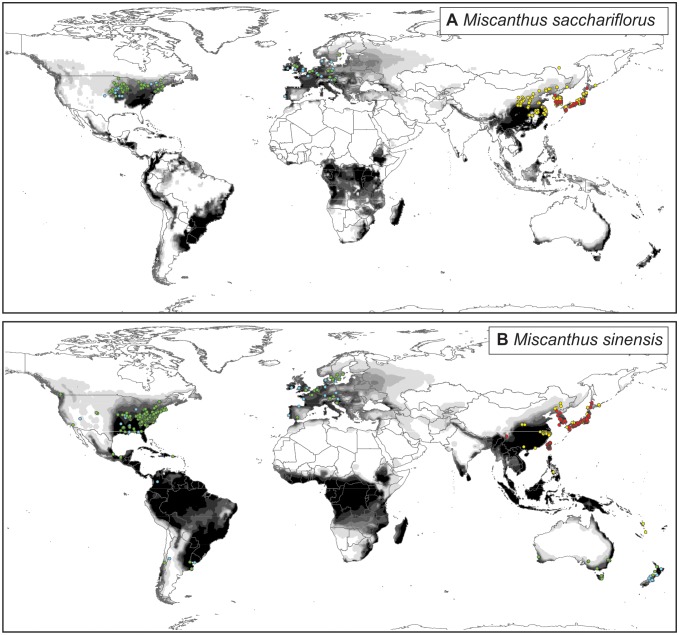
Observed (circles) and modelled (shaded) native and introduced plant distributions.Circles indicate native (red), native inferred (yellow), introduced (green), and introduced inferred (blue) geolocations. The density of shading represents the bioclimatic suitability of a region for plant population persistence, with white areas indicating no suitability, lighter grey areas indicating low suitability, and darker grey areas indicating high suitability. (a) Miscanthus sacchariflorus. Geolocations: native (n = 94), native inferred (n = 171), introduced (n = 119), and introduced inferred (n = 43). (b) Miscanthus sinensis. Geolocations: native (n = 335), native inferred (n = 52), introduced (n = 297), and introduced inferred (n = 81).